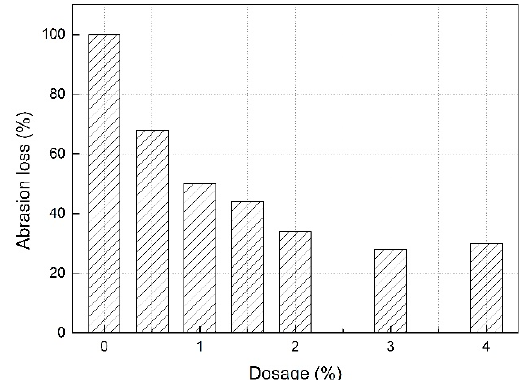
Figure 5. Abrasion loss of SLM with di ff erent dosages of